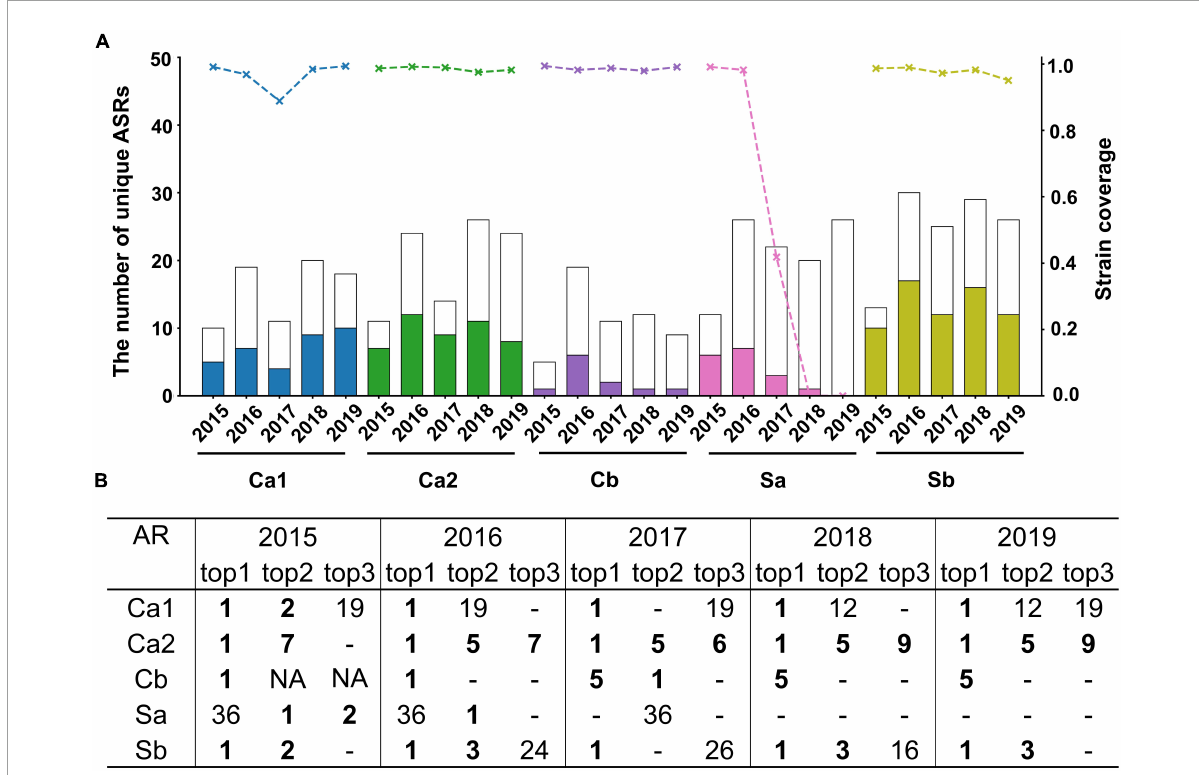
FIGURE1 Prediction performance of A/H1N1 during 2015–2019. (A) Type coverage and strain coverage of five ARs. Each bar shows the total number of unique AR sequences observed in the circulation year, with the colored portion indicating the number of successfully predicted ARs, corresponding to the left axis. The top line indicates the strain coverage for each year, corresponding to the right axis. (B) The ranking in the prediction list for those top 3 dominant ARs observed every year. - indicates the observed variants didn’t be detected in the prediction list, NA indicates that less than 3 dominant variants with abundancy above 5% were observed that